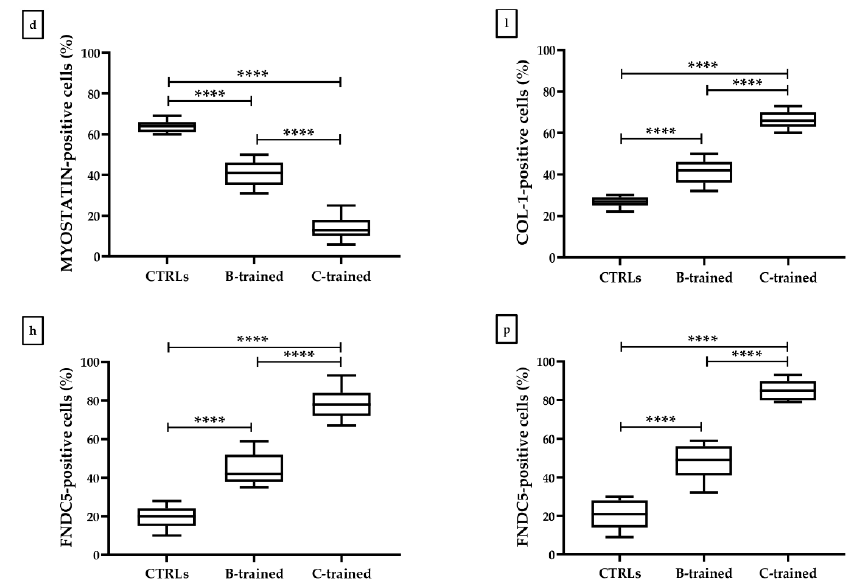
Figure 5. Myostatin, collagen I (COL-1) and fibronectin type III domain-containing protein 5 (FNDC5) expression analysis in muscle and bone tissues of trained and sedentary mice by immunohistochemistry. ( a – c ) Black arrows indicate representative myostatin-positive cells in the muscle tissue. ( d ) The highest number of myostatin-positive cells was found in the muscle of the CTRLs group (**** p < 0.0001; F = 334.9). ( e – g ) Black arrows indicate representative FNDC5-positive cells in the muscle tissue. ( h ) The highest number of FNDC5-positive cells was found in the muscle of the C-trained group (**** p < 0.0001; F = 249.3). ( i – k ) White arrows indicate representative COL-1-positive cells in the bone tissue. ( l ) The highest number of COL-1-positive cells was found in the bone of the C-trained group (**** p < 0.0001; F = 354.9). ( m – o ) White arrows indicate representative FNDC5-positive cells in the bone tissue. ( p ) The highest number of FNDC5-positive cells was found in the bone of the C-trained group (**** p < 0.0001; F = 307.0). For 20× images, scale bar represents 50 μ m.